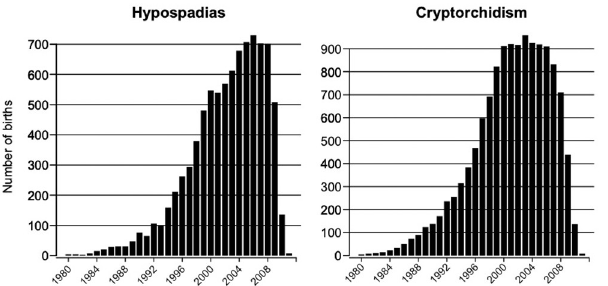
Fig 1. Distribution of the year of birth distribution cases (H: Left, C: